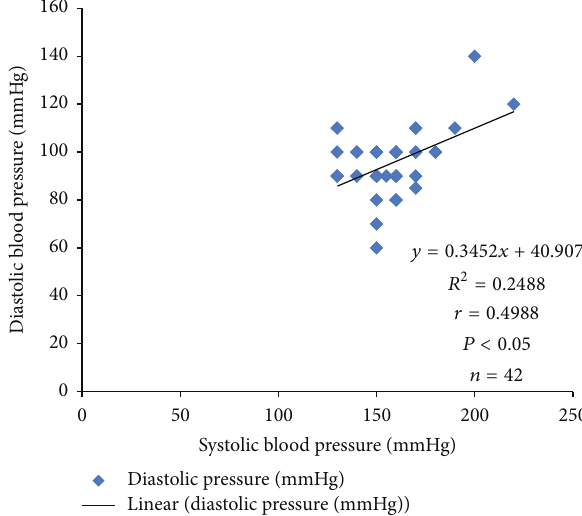
Figure2:Correlationplotofsystolicbloodpressureagainstdiastolic blood pressure in hypertensive patients.